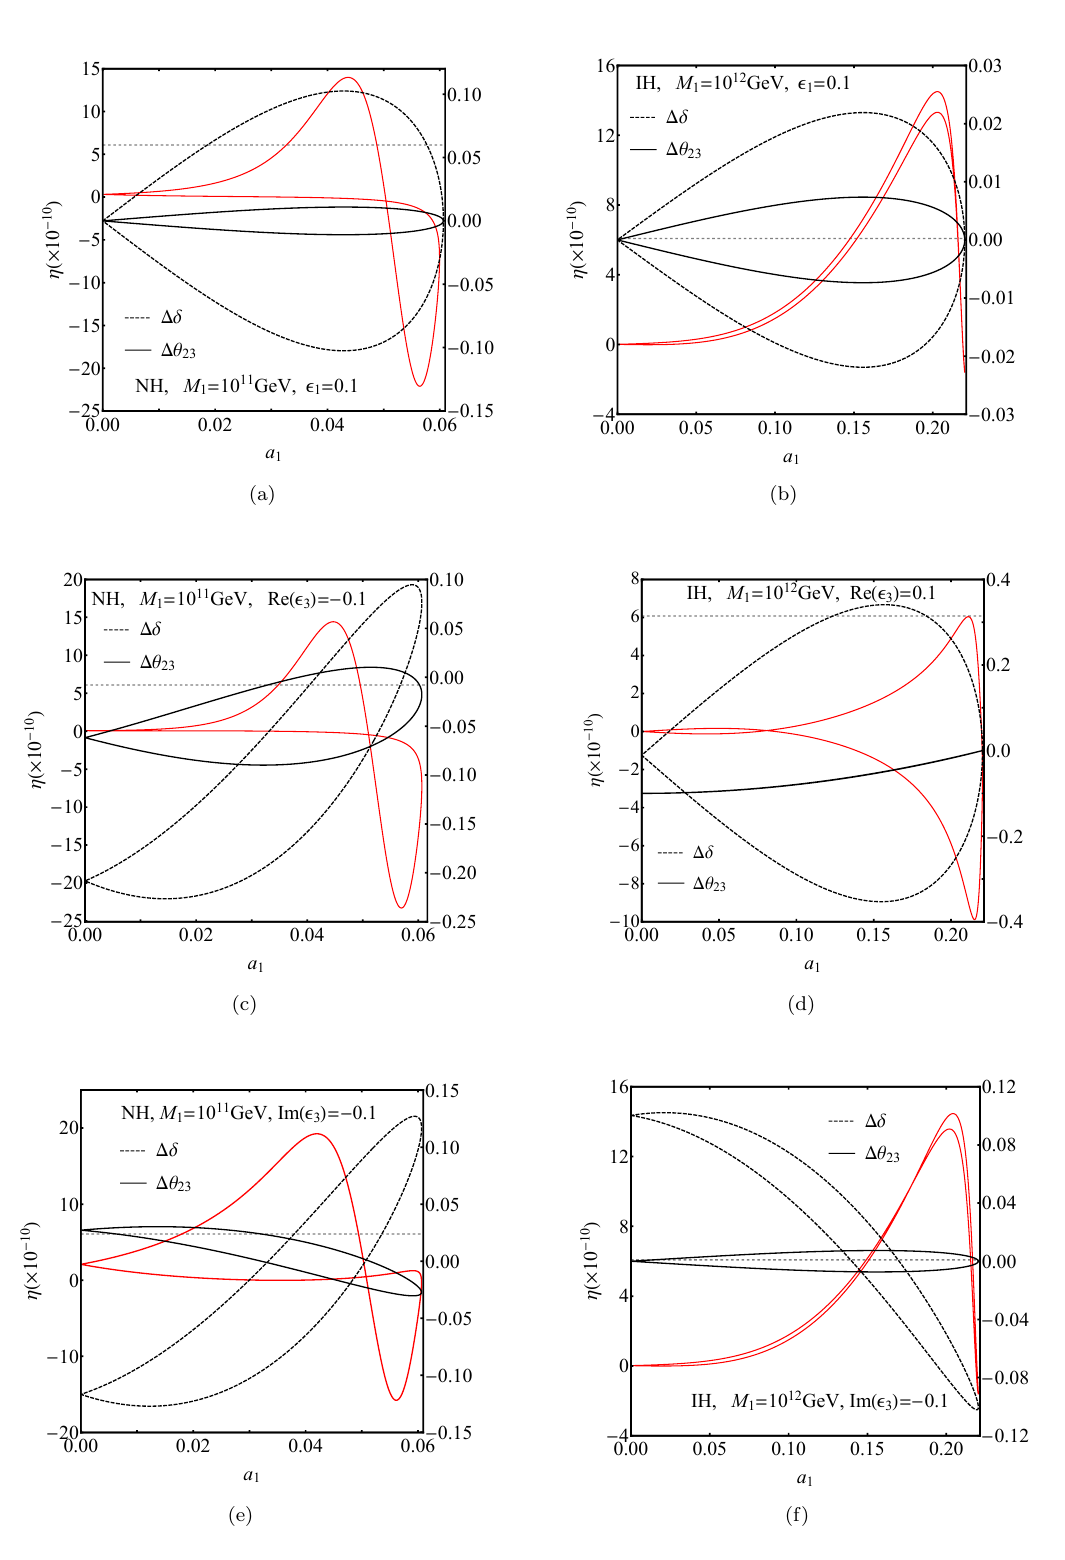
Figure 7 . The resulting (cid:1) (cid:14) and (cid:1) (cid:18) (cid:12)gure 5 that can lead to successful leptogenesis. The red line is used to denote the corresponding (cid:17)